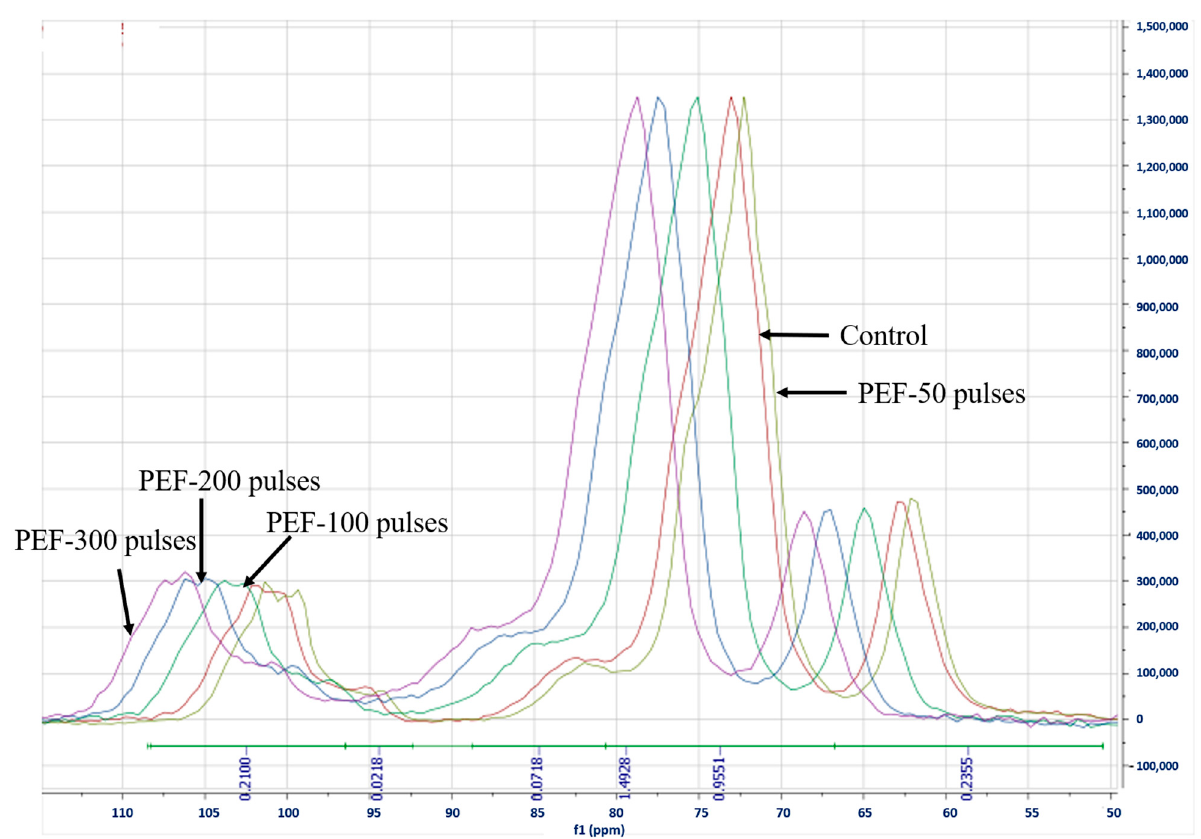
Figure 4. 13 C cross-polarization magic angle (CP/MAS) nuclear magnetic resonance (NMR) spectra of control and PEF treated glutinous rice flour at the field strength of 3 kV/cm for 50, 100, 200 and 300 pulses.